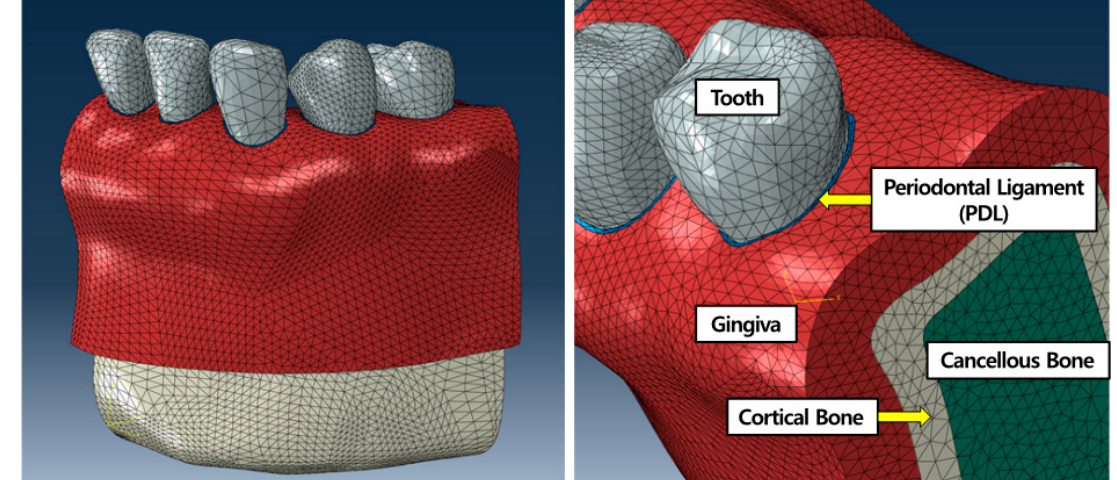
Figure 1. Intact dental finite element (FE) model showing the teeth, gingiva, PDLs, and cortical and cancellous bones.